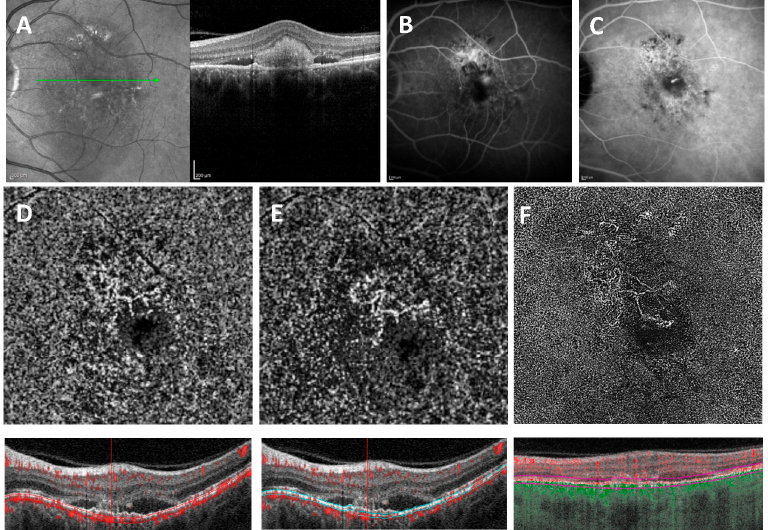
Figure 4. ( A ) SD-OCT crossing through the lesion showing a flattened irregular PED with sub-reti- nal hyper-reflective material. ( B ) Early fluorescein angiography. ( C ) Late indocyanine green angi- ography with late hyperfluorescent plaque. ( D ) En face and cross-sectional 6 × 6 mm 2 SD-OCTA with AngioVue automated segmentation showing no distinct detectable flow. ( E ) En face and cross- sectional 6 × 6 mm 2 SD-OCTA with AngioVue corrected manual segmentation. ( F ) En face and cross- sectional 6 × 6 mm 2 SS-OCTA with PlexElite MS Custom segmentation showing distinct flow over- lay.